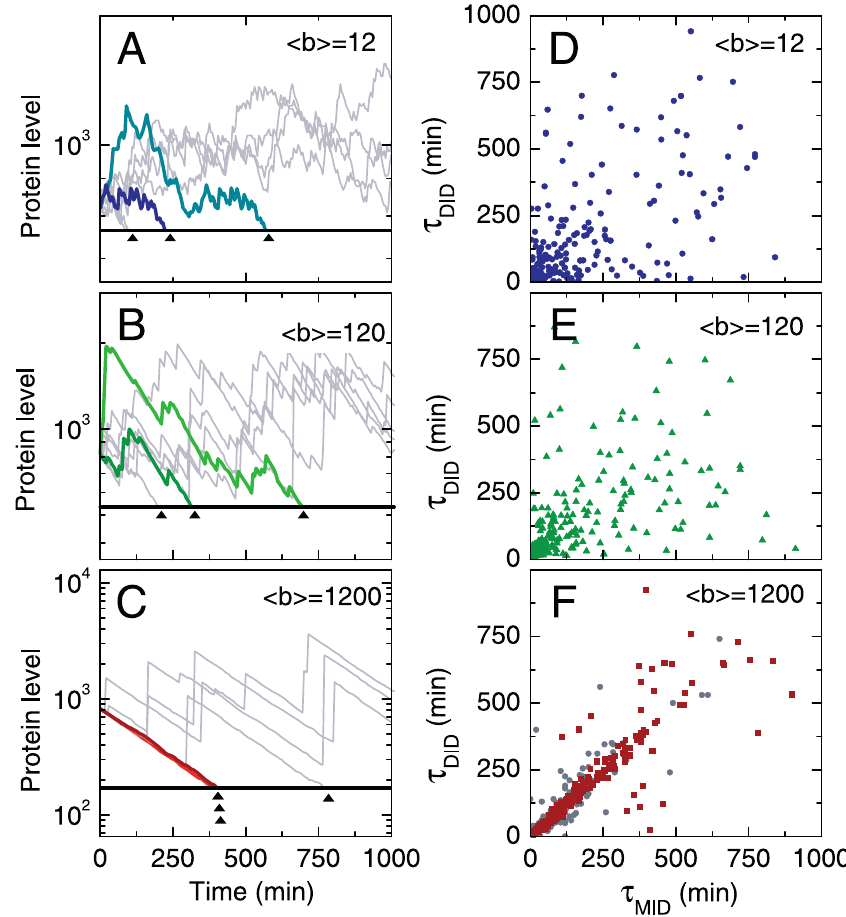
Figure 5. Burst-Induced